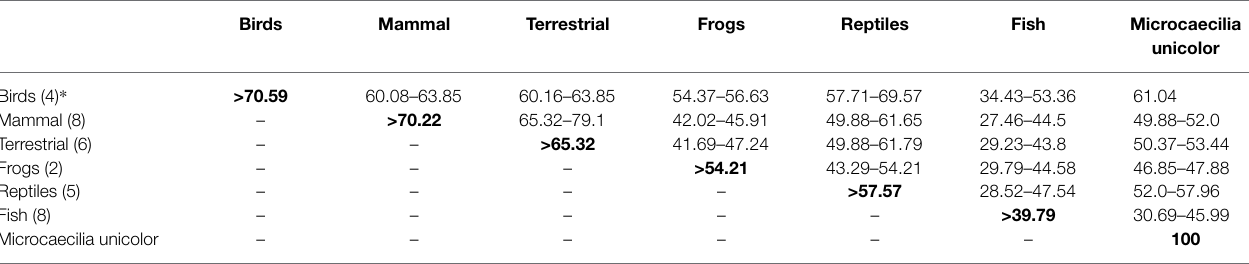
* The number of reference sequences for each species was indicated in brackets. Homology within species are shown in